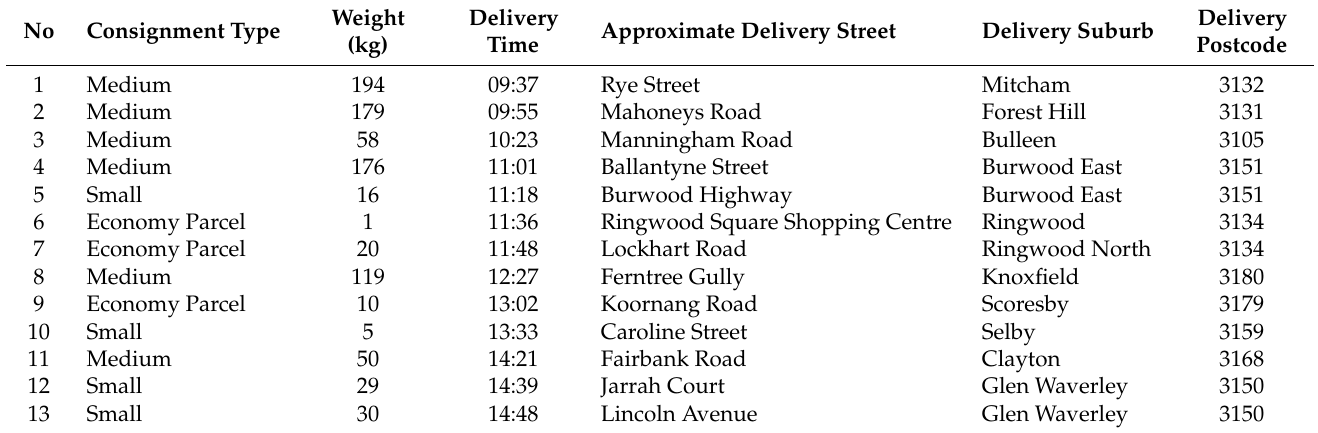
Table 3. Consignment delivered during the field-trial.